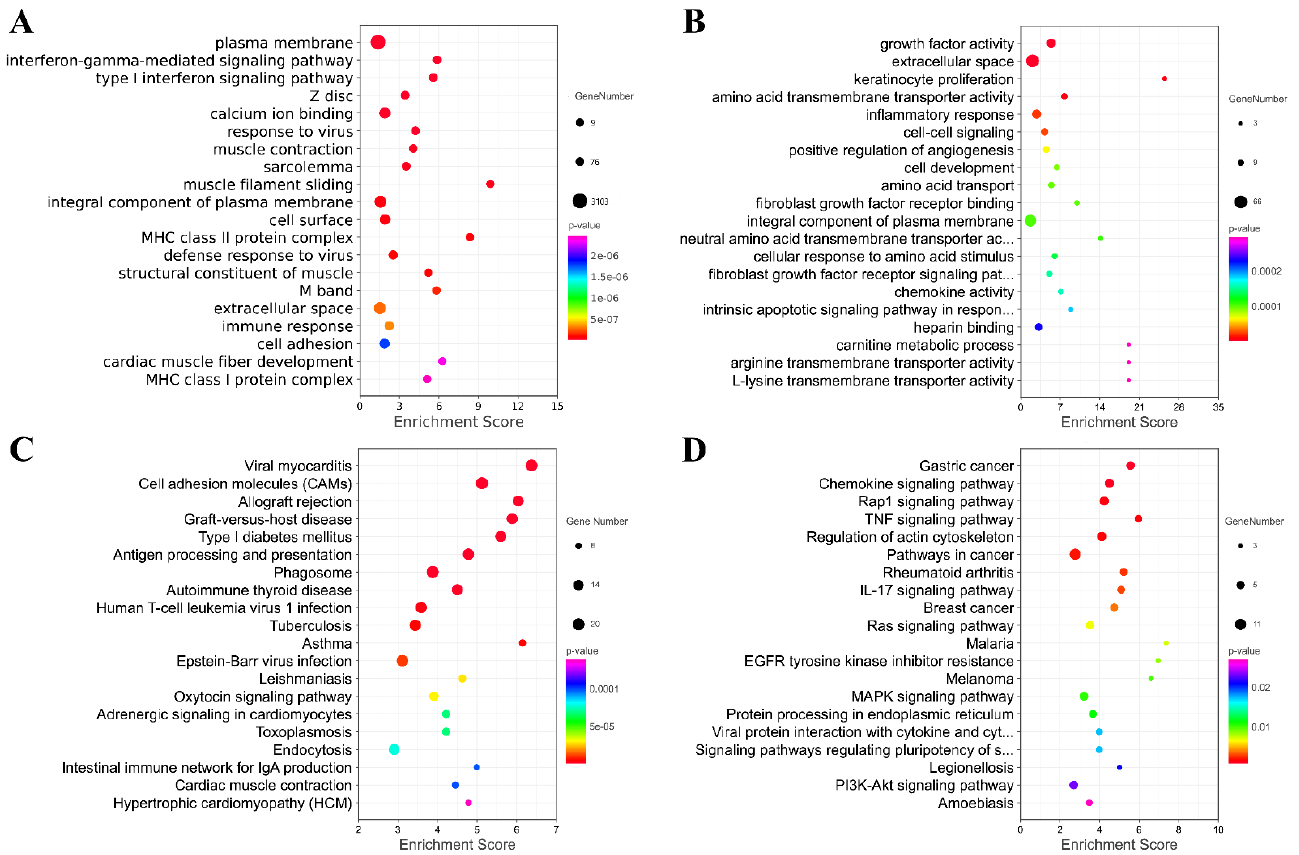
Figure 7. Analysis of GO and KEGG Pathway. Top 20 GO pathways enriched by up-regulated or down-regulated mRNA. ( A ) Top 20 GO pathways enriched by up-regulated mRNA; ( B ) Top 20 GO pathways enriched by down-regulated mRNA; ( C ) Top 20 KEGG pathways enriched by up-regu- lated mRNA; ( D ) Top 20 KEGG pathways enriched by down-regulated mRNA.